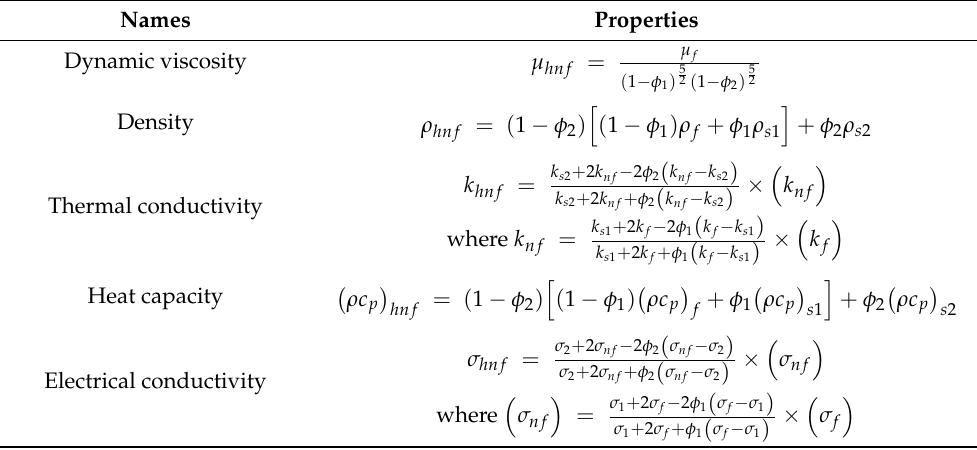
Table 1. Thermophysical properties of a hybrid nanofluid [33].